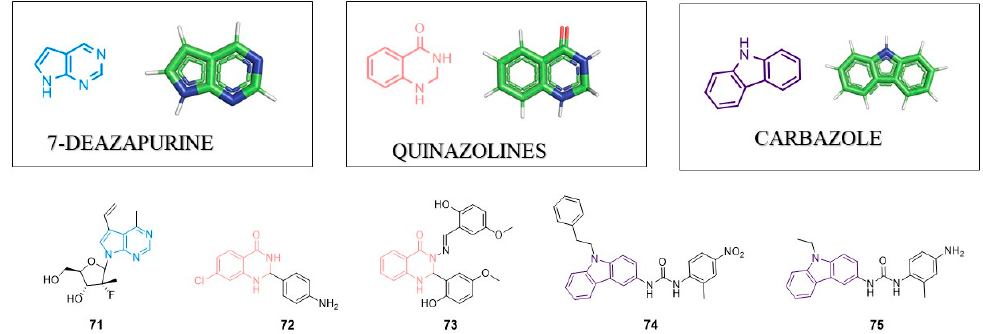
Figure 7. Examples of antivirals wit 7-deazapurine, quinazoline and carbazole moiety.